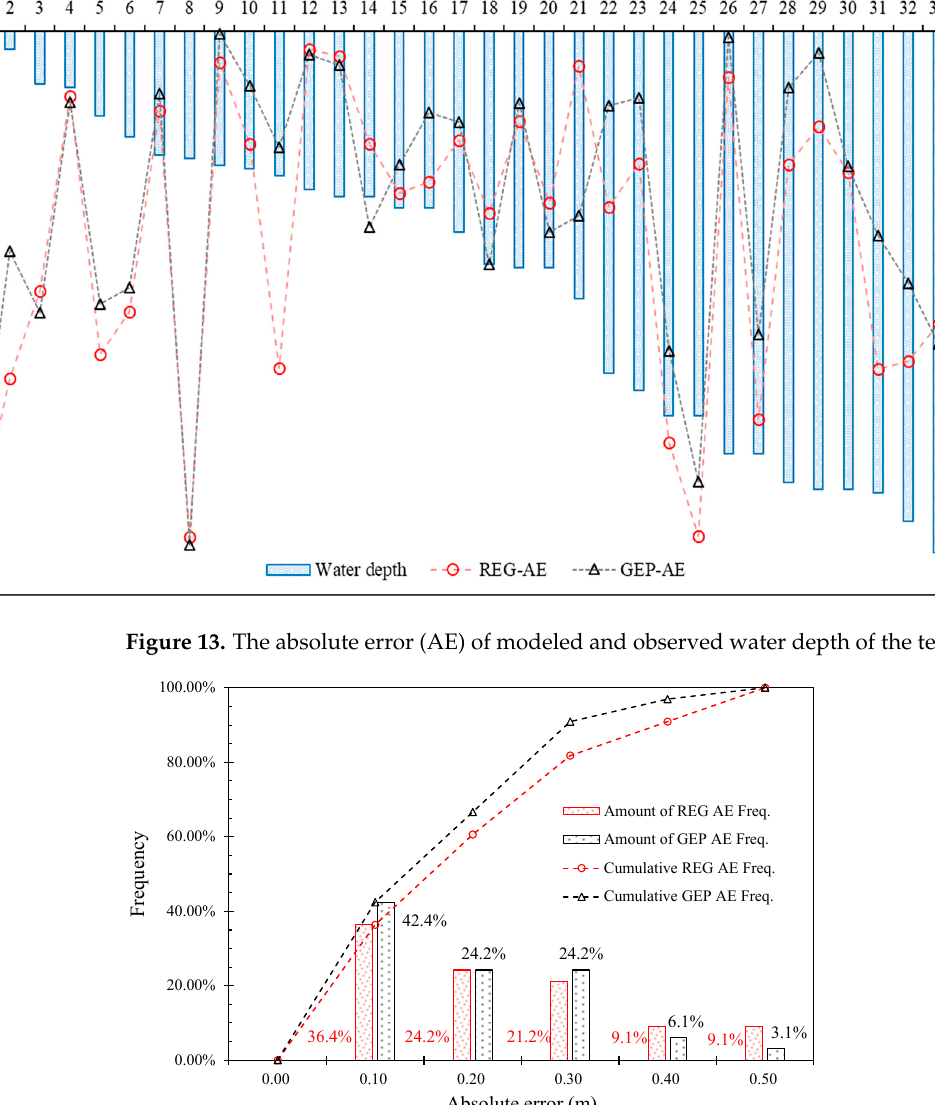
Figure 14. Frequency distribution of water depth AE of the testing dataset.